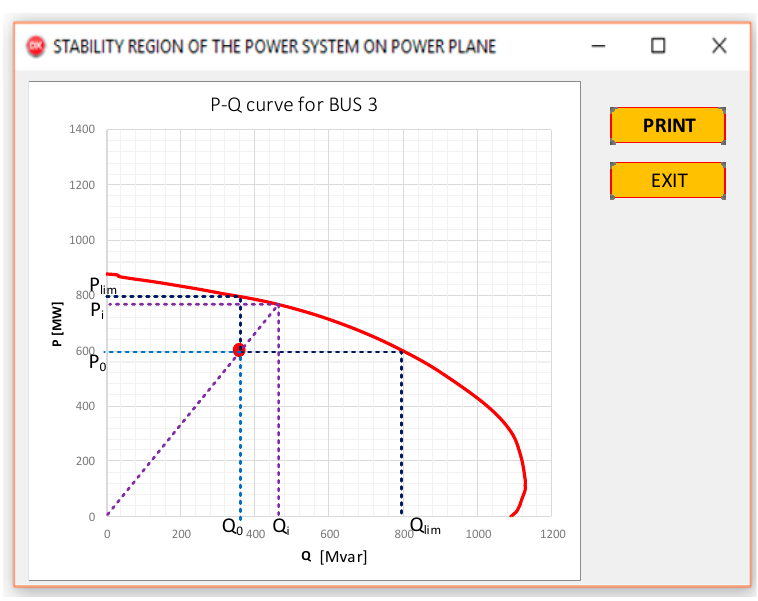
Figure 15. Calculating the stability reserve ratios for the operating region at Bus 3. Table 2. Comparison of the results. Comparison of Paramaters